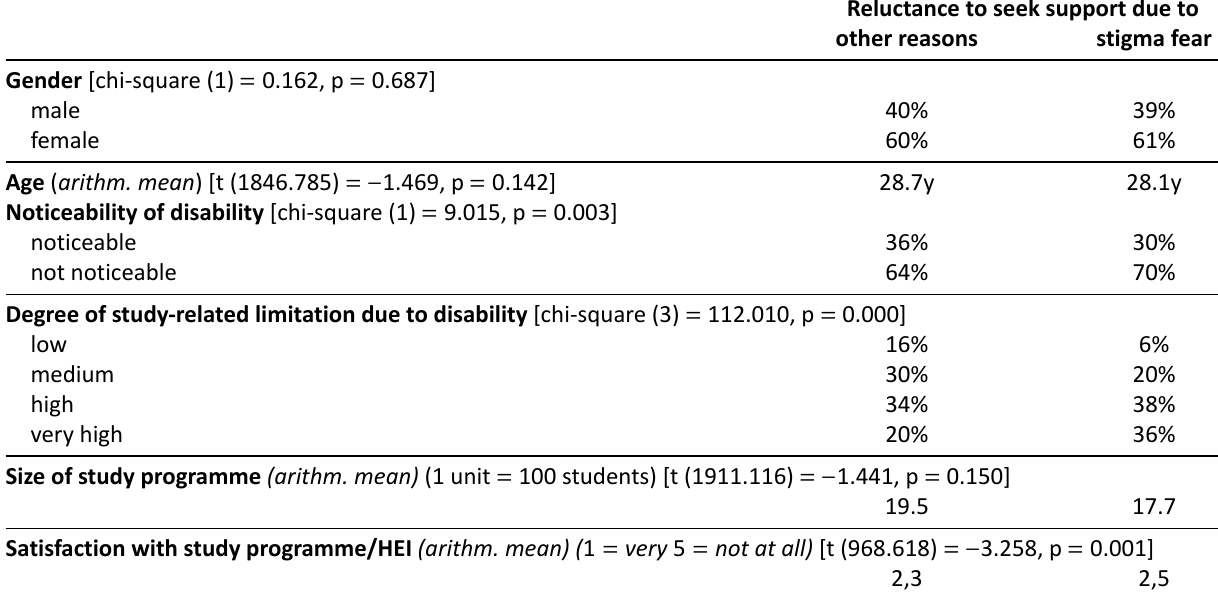
Reluctance to seek support due to other reasons stigma